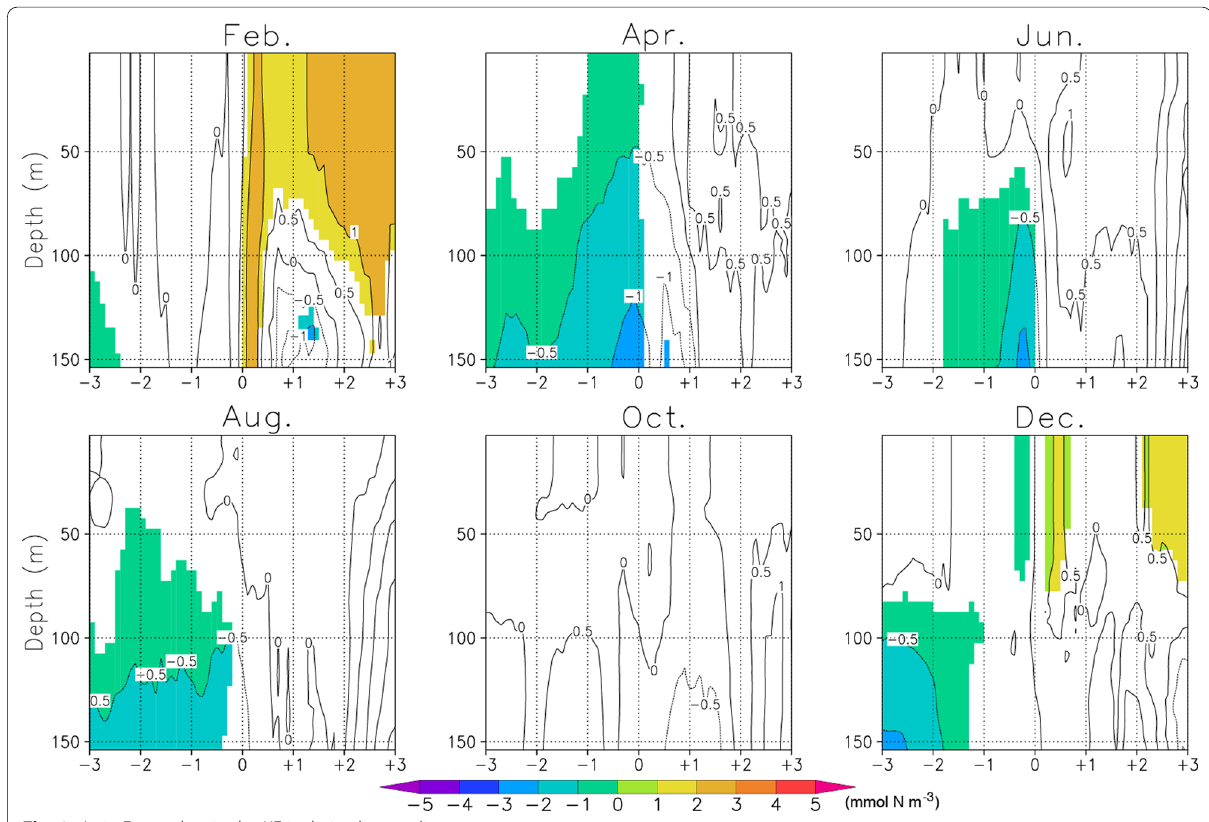
Fig. 8 As in Fig. 7a, but in the KE jet latitude